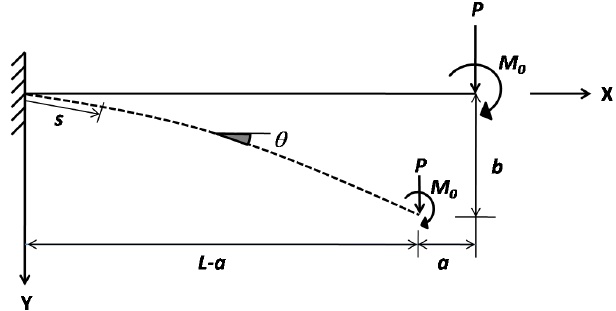
Figure 4. Flexible joint as a cantilever beam subjected to end point load and